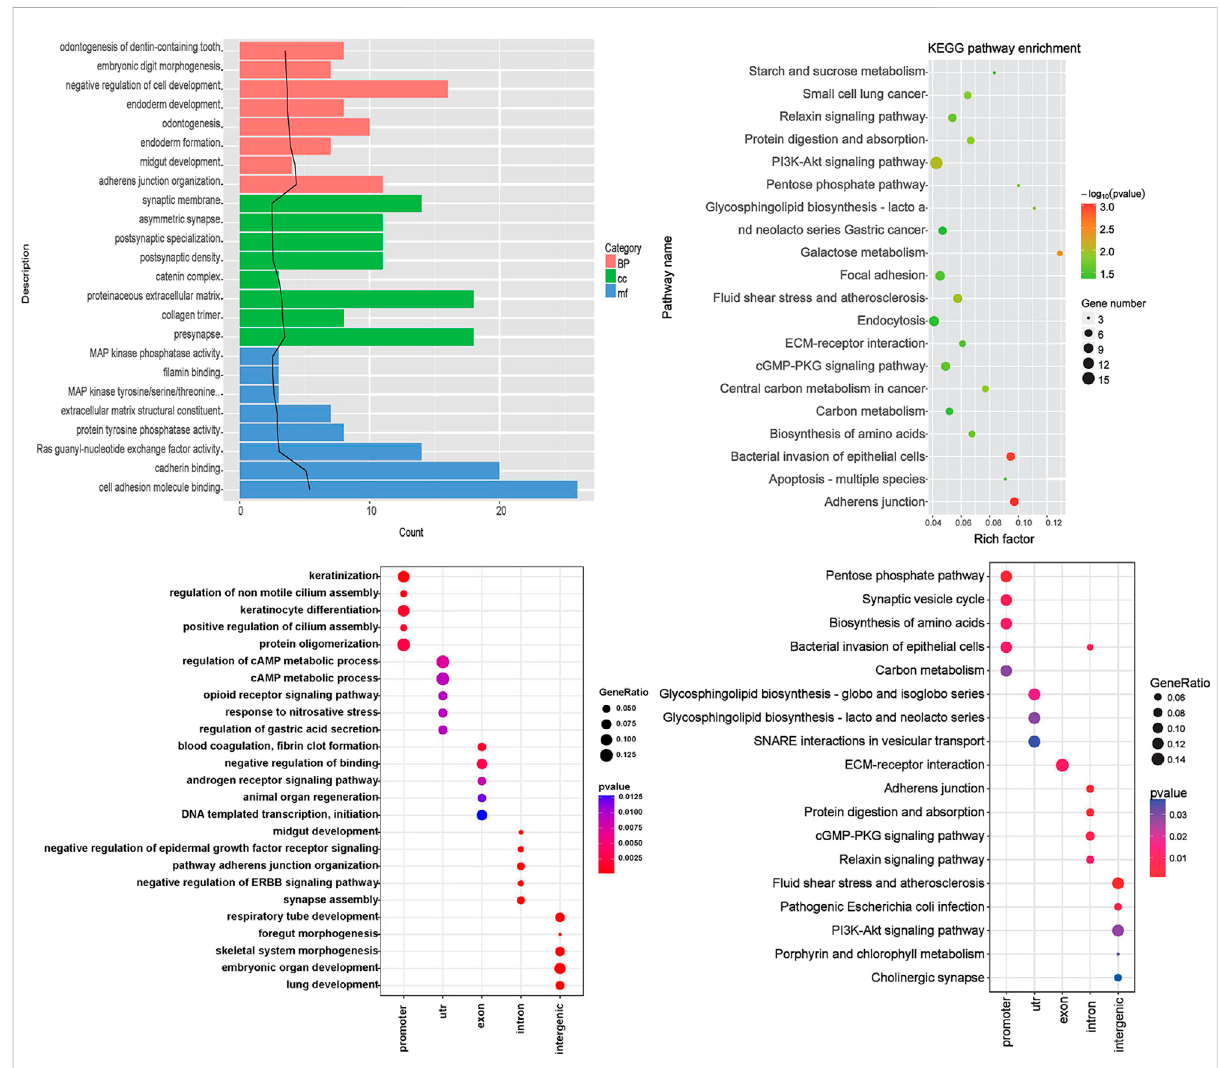
FIGURE 3 Functional enrichment analysis. (A) Gene ontology (GO) enrichment analysis. Category: the category of GO, BP: biological pathway, CC: cell composition, MF: molecular function, term: GO function description information, count: the number of differential genes enriched in the term; the blacktrendlinerepresentsthe-log10( p Value)value. (B) TheKEGGpathwayenrichmentanalysisresultsofdifferentialgenes.Therichfactorrefersto the ratio of the number of differentially expressed genes in the pathway to the total number of genes in the pathway. The size of the rich factor represents the degree of enrichment. (C) Enriched biological pathway of fi ve kinds of genes; (D) KEGG pathway of fi ve kinds of genes. The abscissa represents the group name, and the ordinate represents the enrichment entry